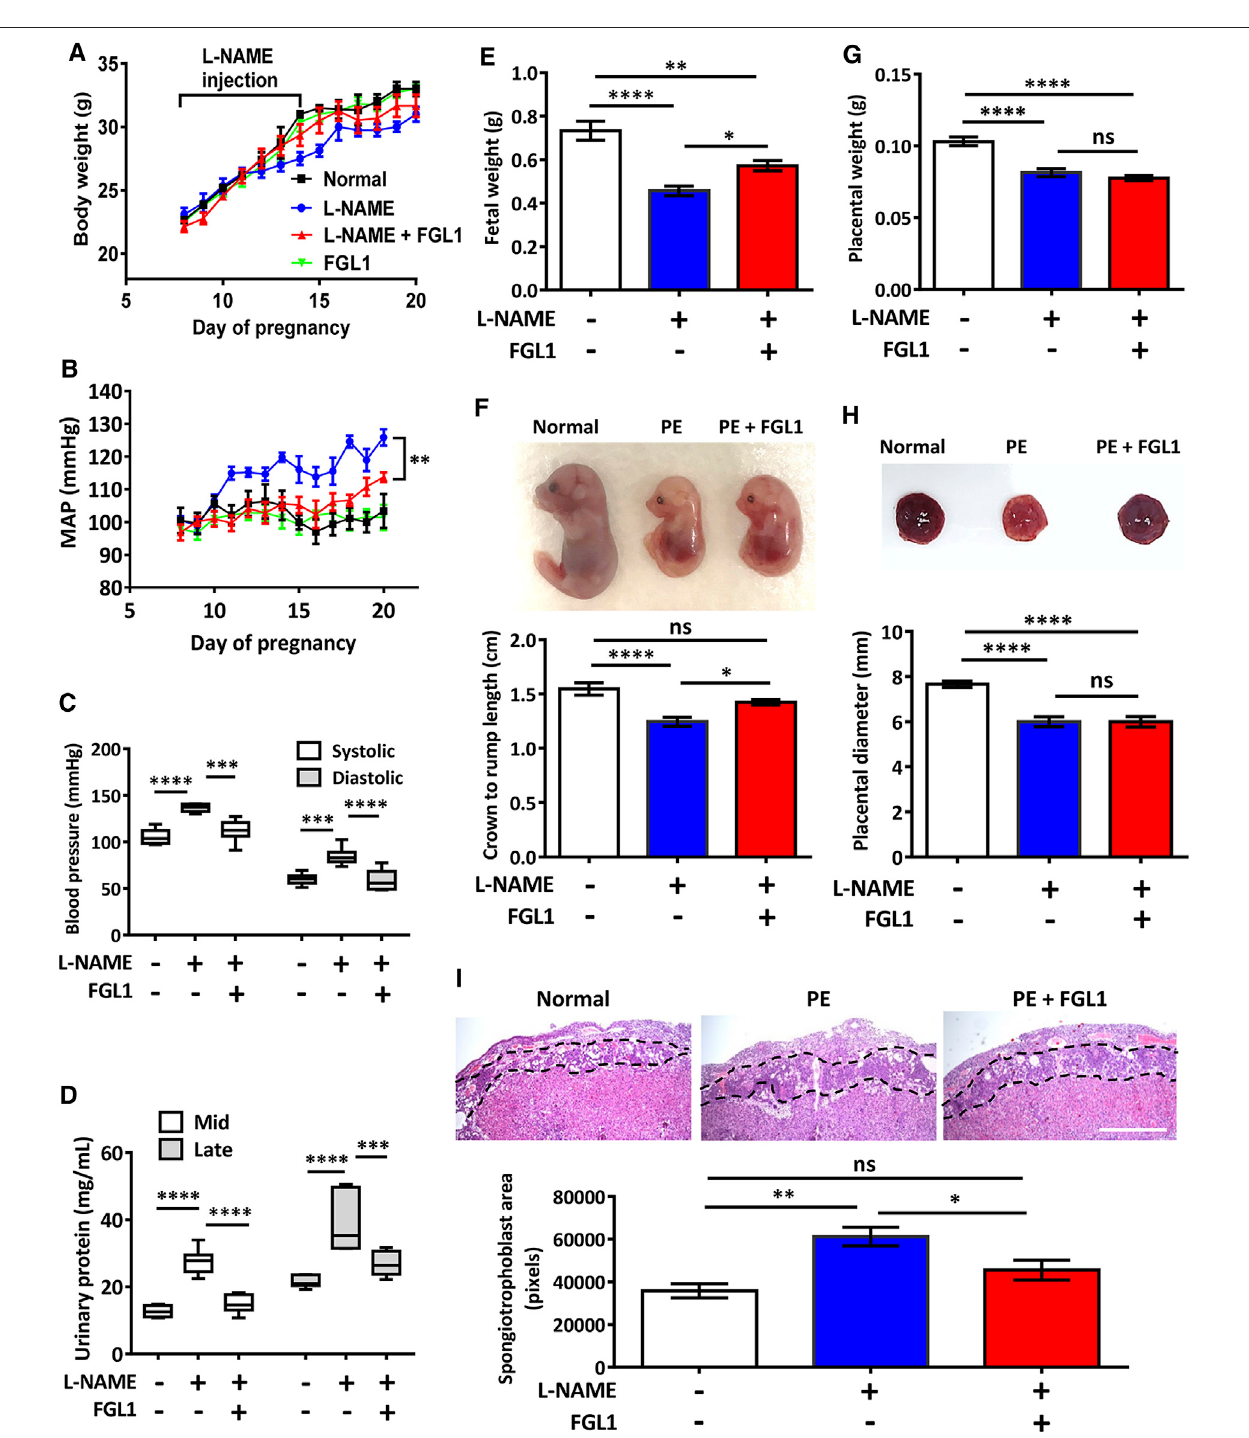
FIGURE 3 | Effects of FGL1 treatment on the PE mouse. After the injection of L-NAME with or without FGL1 into pregnant mouse, representative parameters, including body weight (A) , mean arterial pressure (MAP) (B) , blood pressure (C) , urinary protein (D) , fetal weight (E) , crown-to-rump length of the fetus (F) , placenta weight (G) , and placenta diameter (H) , were analysed. Box and whisker plots for blood pressure and urinary protein. The box represents the median and interquartile range (IQR), andthe whiskers weregeneratedusing Tukey ’ smethod (values upto75thpercentile +1.5IQR). (I) Hematoxylin-eosinstainingofthe mouseplacenta. Dottedlineindicates the spongiotrophoblast area.Mid, 12 – 15 days ofpregnancy;late, 15 – 18 days ofpregnancy.Scalebar, 10 mm. n (cid:1) 6/group.* p < 0.05; ** p < 0.01; *** p < 0.001; **** p < 0.0001; ns, no signi fi cance [ (A, B) : two-way ANOVA test; (C – I) : Tukey ’ s test].